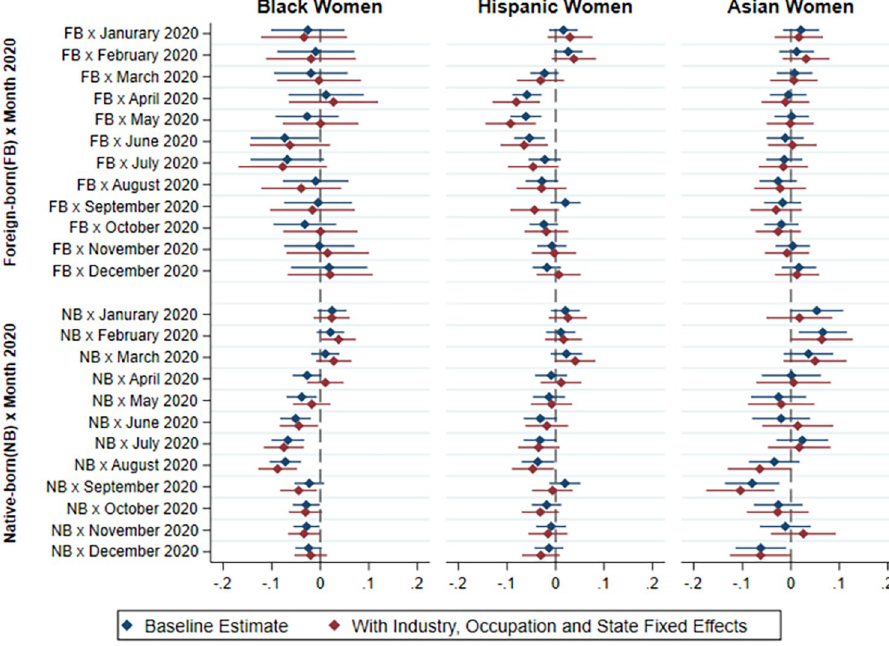
Fig 8. Difference in probability of full-time employment between non-White and native-born White women by immigrant status and race/ethnicity in 2020 relative to 2019 (with industry, occupation and state fixed effects).